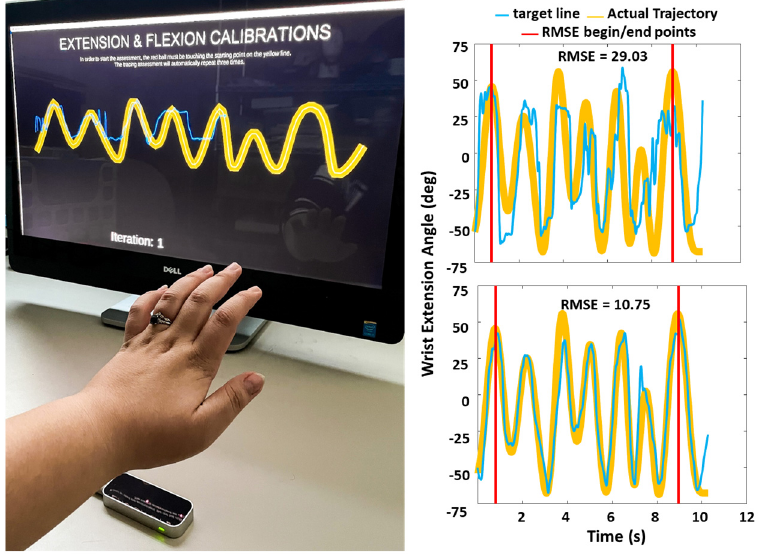
Figure 3. Accuracy Measures. Left : Photograph of subject performing Hand Opening Accuracy test. On the screen the thick yellow line is the target wave and bright blue line is generated by cursor, which is controlled by the subject. Subject is cued to keep the bright blue line within the yellow line. Note: Leap Motion Controller and table top arm support are positioned to optimize this photograph. Please see methods for actual positioning. Right : Calculation of accuracy measures. Examples of two representative performances and results for the WEA measure. Vertical red lines depict beginning and ending of data collection for Root Mean Square Error calculation. Yellow lines represent target line. Blue lines represent line generated by cursor controlled by subject flexing and extending their wrist. Scores for these two performances are in each